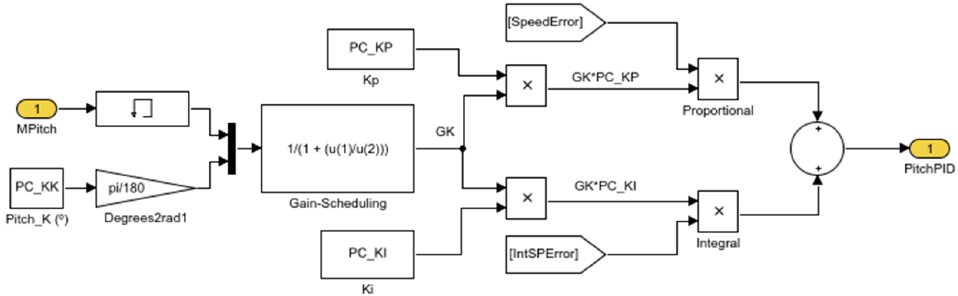
Figure 4. Simplified block diagram and implementation of the reference PI in Simulink.